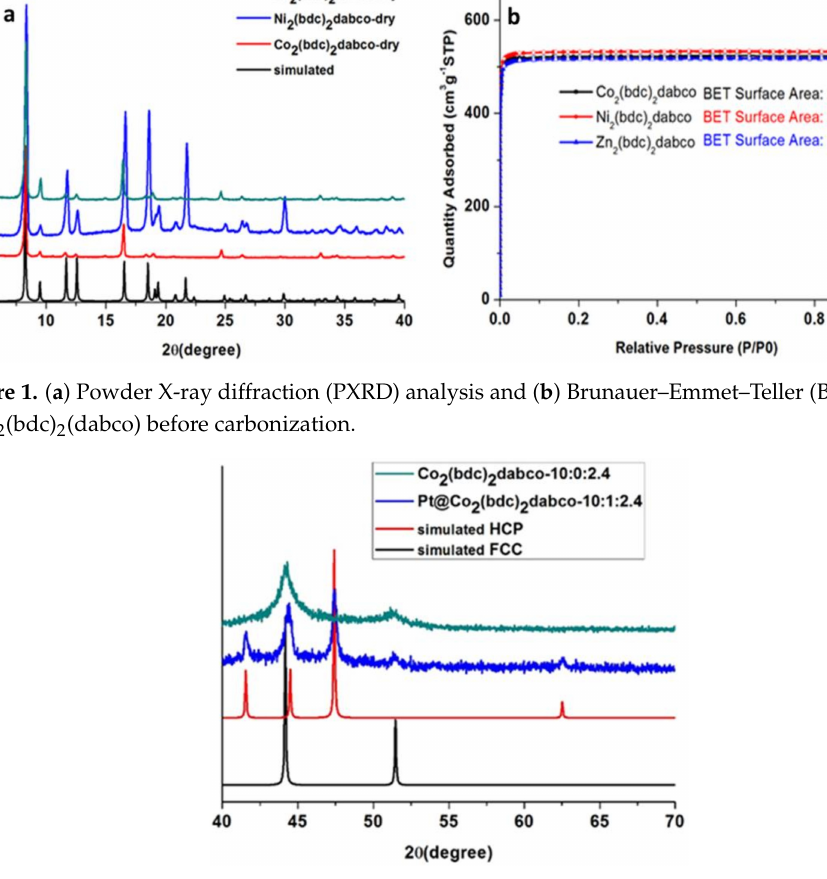
Figure 2. PXRD analysis, after carbonization, of Pt@Co/C(10:1:2.4) and Co/C carbinized at 800 ◦ C for 4 h under